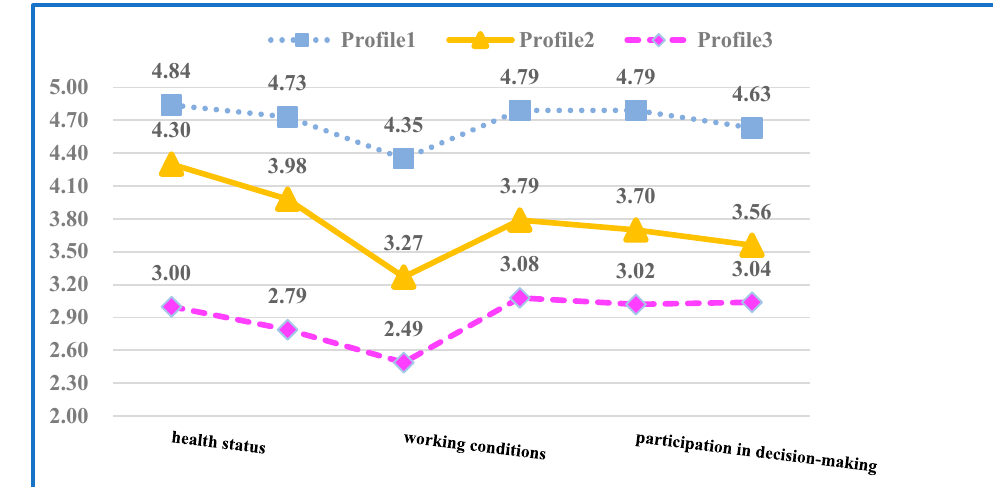
Figure 2. The three profiles based on mean evaluation scores on the quality of work life scale for kindergarten teachers (QWLSKT) (N = 936). Profile 1 = high level ( n = 383); profile 2 = middle level ( n = 384); profile 3 = low level ( n = 309). AIC, Akaike information criteria; BIC; Bayesian information criteria; LRT, likelihood-ratio test; BLRT, bootstrap likelihood ratio test. Table 4. Latent profile analysis model-fit statistics of the potential models.